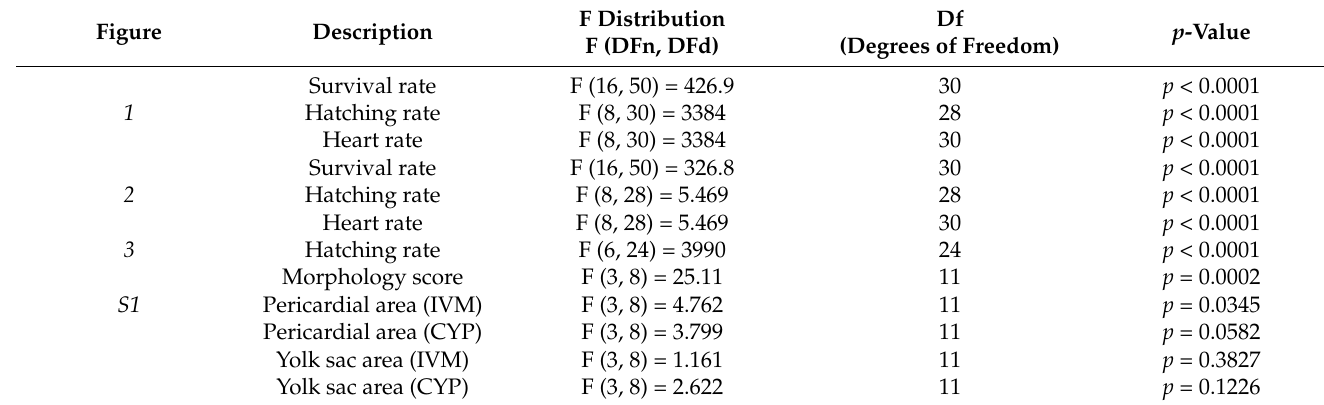
Table 1. The statistical data of F distribution, degrees of freedom and p value.